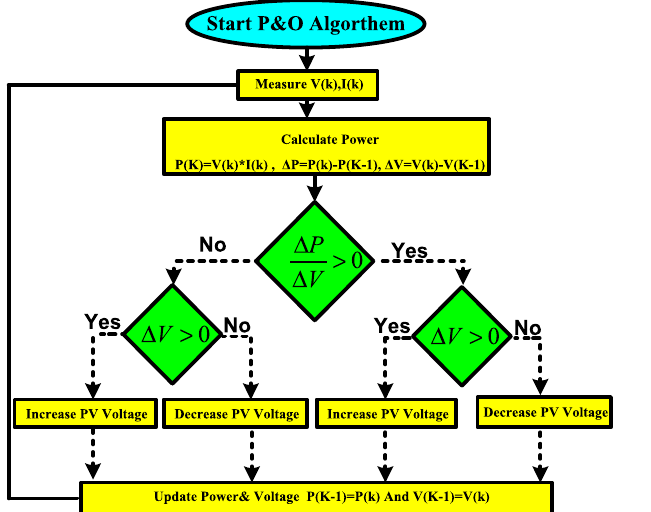
Figure 3. Flowchart of perturb and observe scheme.